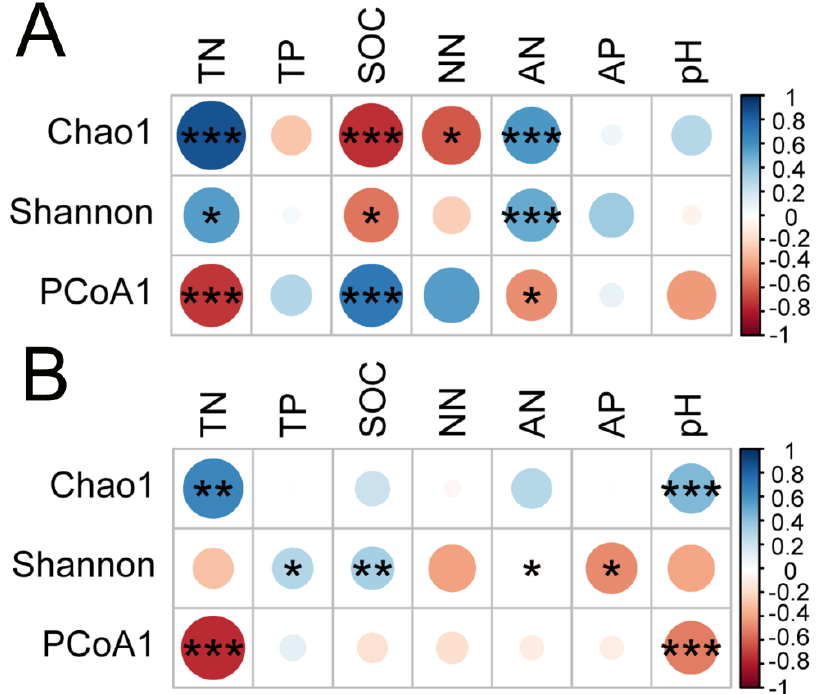
Figure 6. Spearman’s rank correlation coefficients between soil properties and microbial varieties (Chao1 and Shannon index; PCoA) at 0–20 cm soil depth ( A ) and 20–40 cm soil depth ( B ), respectively. *, ** and *** indicate obvious difference at p < 0.05, p < 0.01 and p < 0.001 between soil properties and microbial Chao1, Shannon index; PCoA.